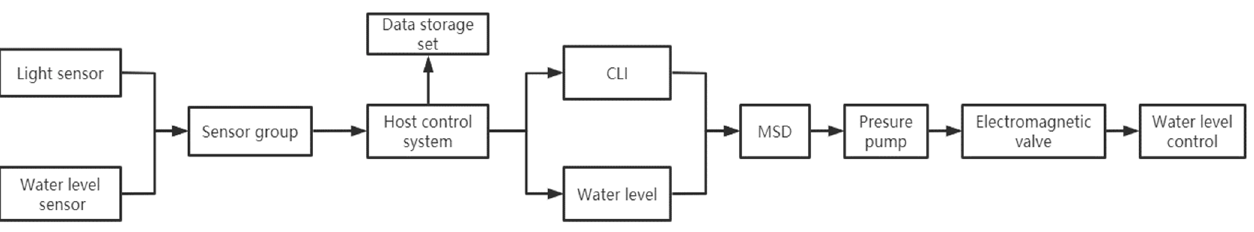
Figure 2. Flowchart of system operation.